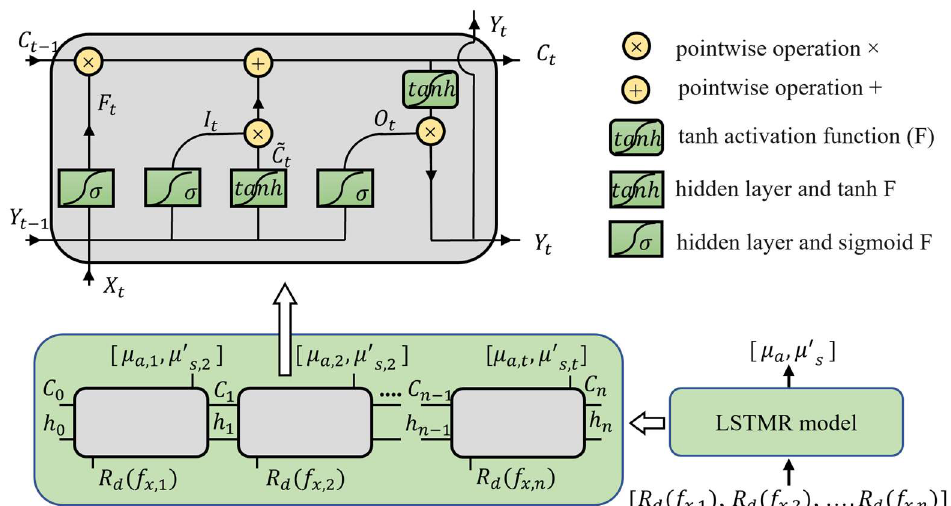
Figure 2. The Long Short-term Memory Regressor Model.